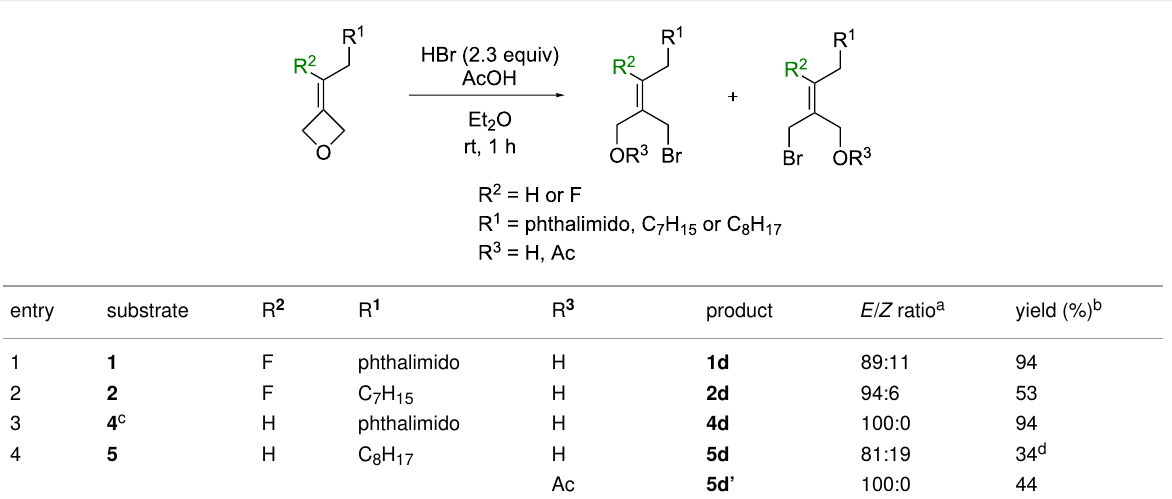
Table 2: Selectivity in the presence or absence of the fluorine atom.